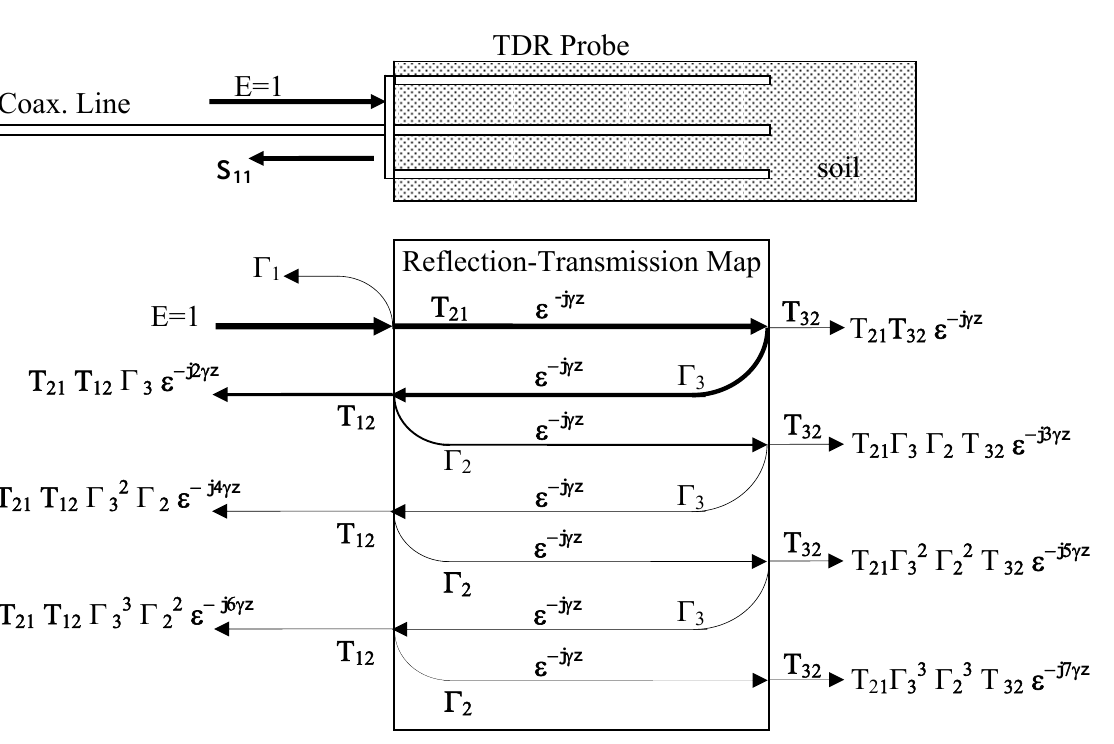
to the soil-probe o